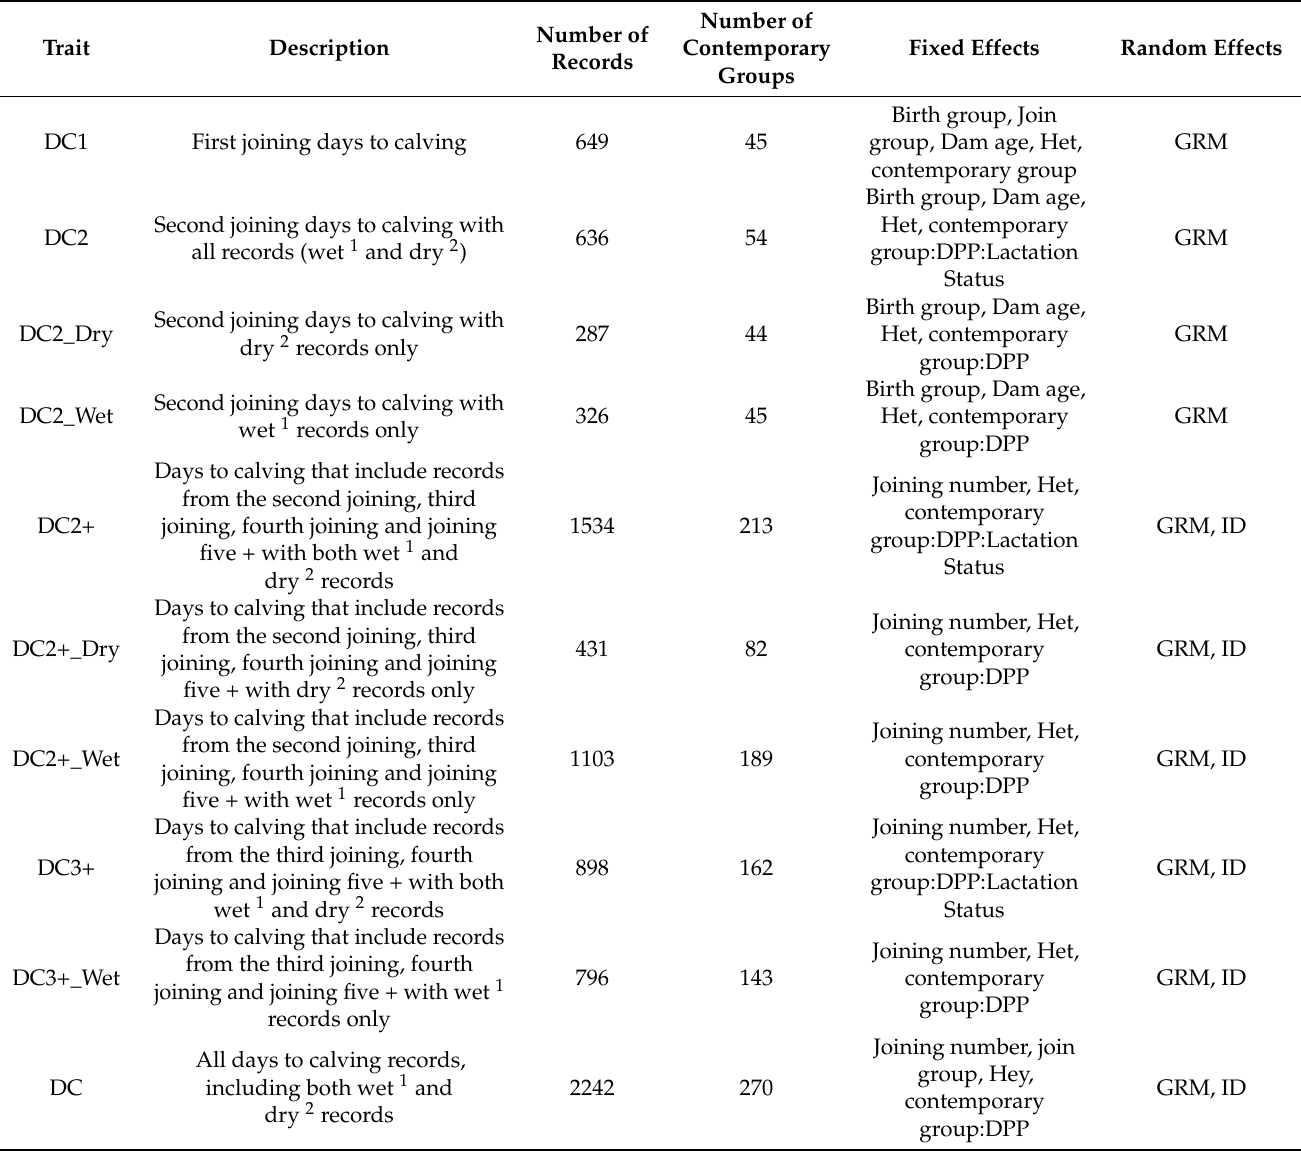
Table 3. Description of the fixed effects included first joining days to calving (DC1), second joining days to calving (DC2) and mature joining days to calving